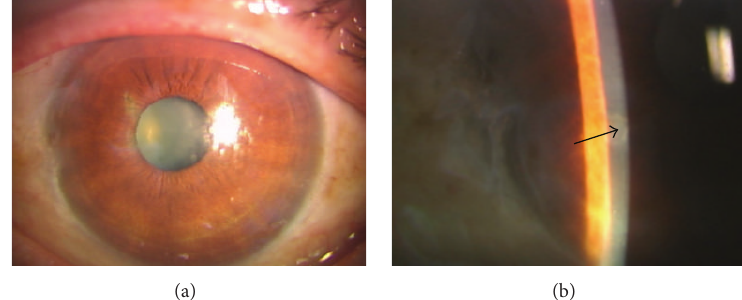
Figure 2: (a) One month after the removal of the lesion. The lesion did not recur. (b) Stroma beneath the original tumor is somewhat opaque